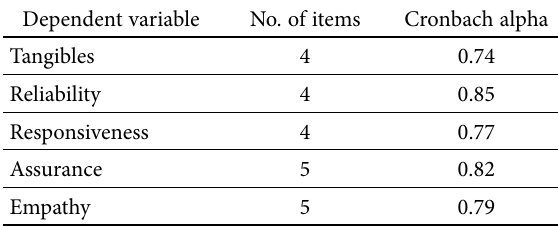
Table 2. Reliability coefficients of five SERQUAL dimensions